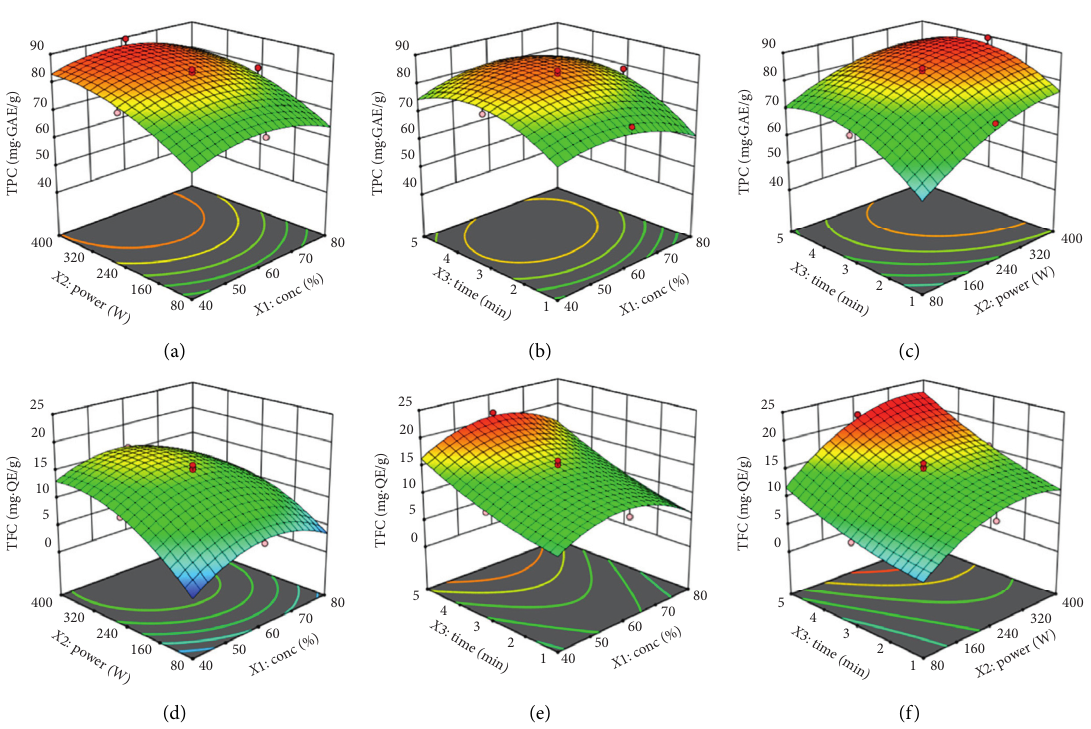
Figure 1: Response surface plot showing the interactive effect of MAE variables on TPC ((a)–(c)) and on TFC